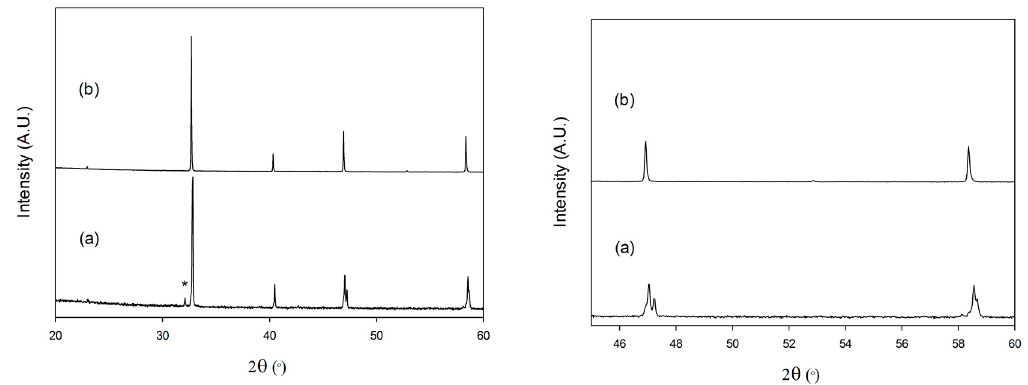
Figure 3. X-ray diffraction patterns for ( a ) SrFe 0.95 O 3- δ (Fe-deficient, no sulfate) and ( b ) SrFe 0.95 S 0.05 O 3- δ . The data show impurities (highlighted by an asterisk) and a tetragonal cell for SrFe 0.95 O 3- δ , while the sulfate-containing sample SrFe 0.95 S 0.05 O 3- δ is phase pure and cubic.